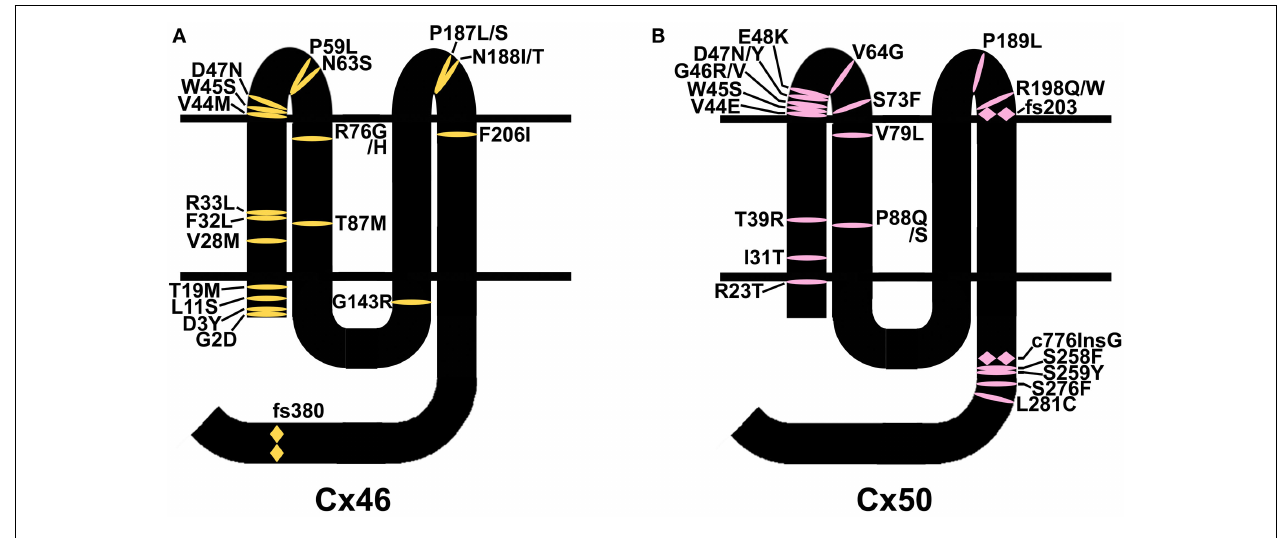
FIGURE 3 | Diagram illustrating the topology of the human lens connexins, Cx46 (A) and Cx50 (B) and the locations of missense ( ) and frame shift ( ) mutations identified in members of families